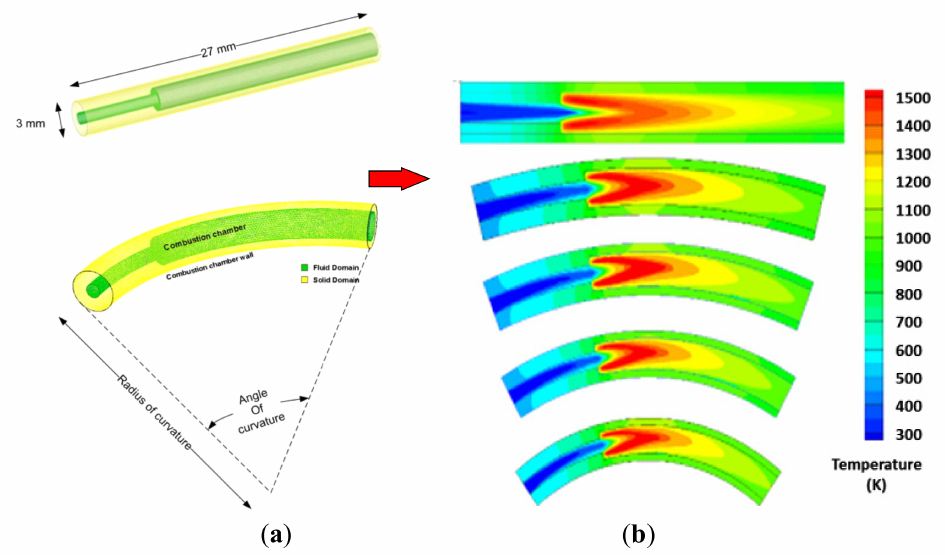
Figure 21. Computational domain of a straight channel and temperature contours, ( a ) Computational domain of a straight channel, ( b ) Temperature